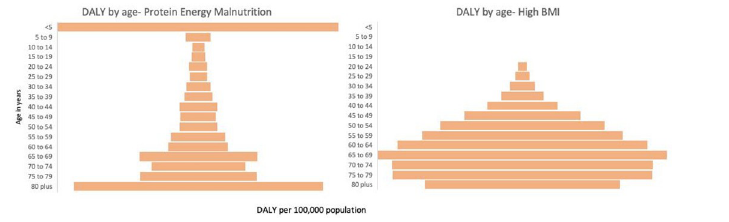
Fig 2. Age-Wise distribution of DALY for PEM and High BMI in Nepal (2019).